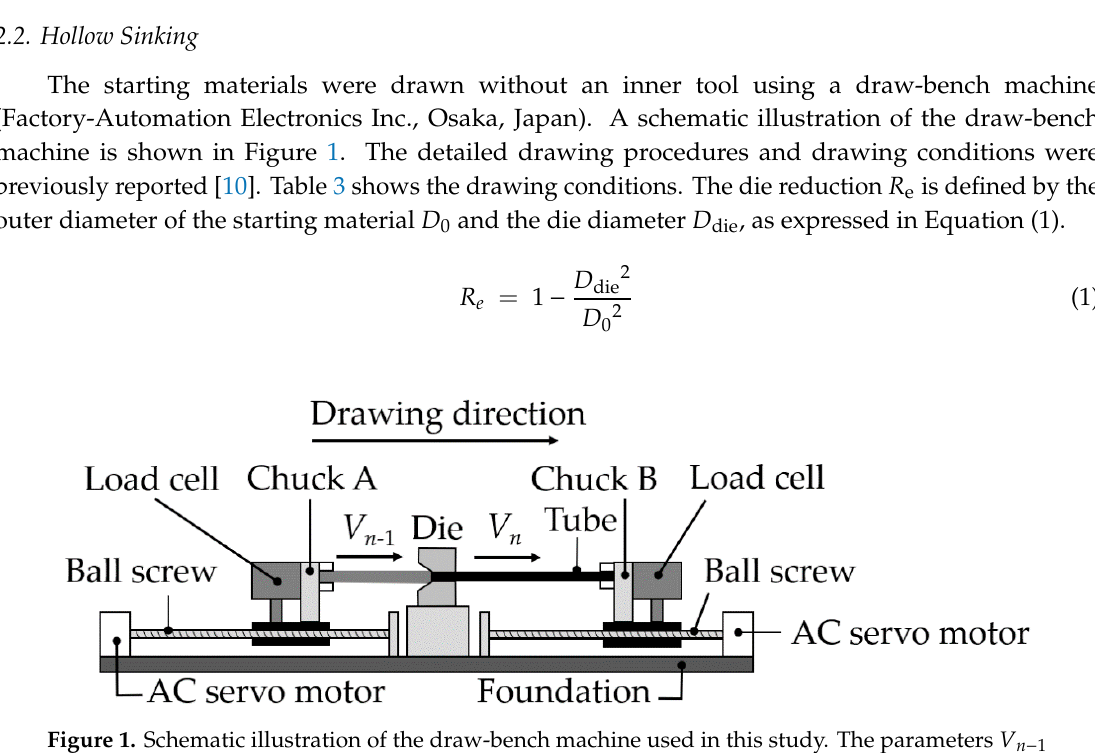
Table 2. Chemical composition of the aluminum alloy (A6063) tube used in this study (mass percentage).